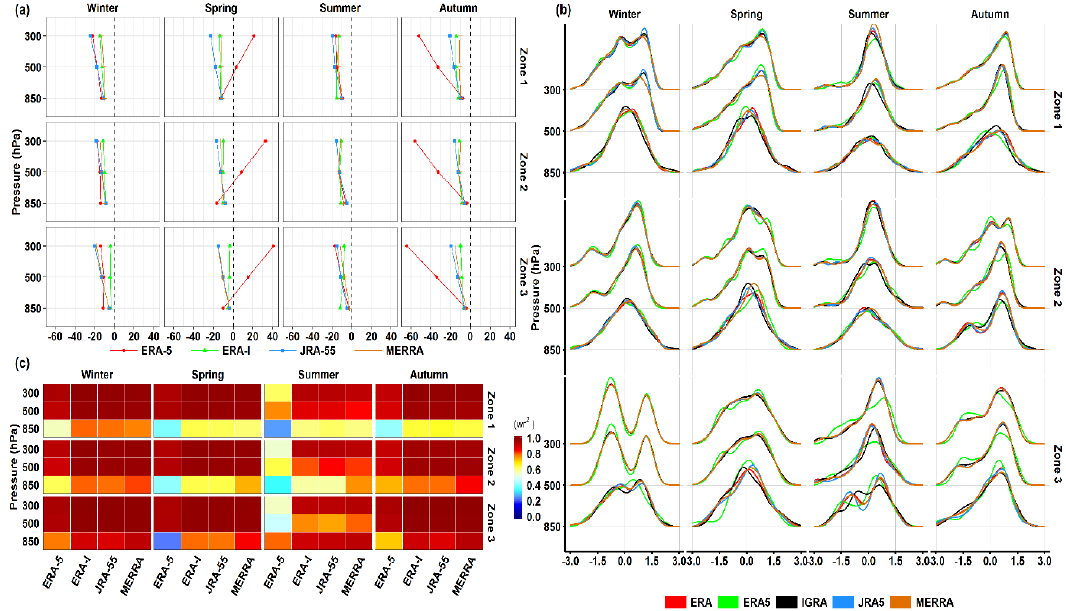
Figure 7. Seasonal comparison of vertical mean biases ( a ), PDF ( b ) and weighed coefficients ( c ) of geopotential height (m).